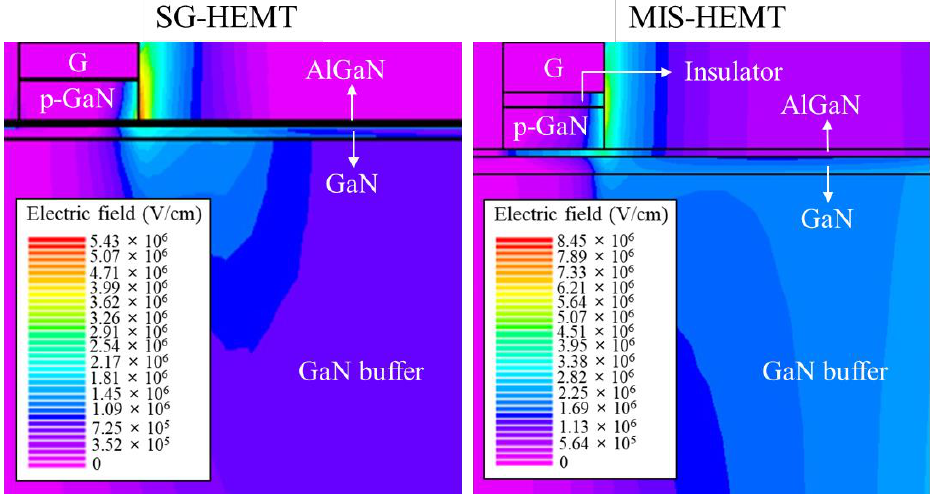
Figure 4. Electric field distributions of the SG-HEMT and MIS-HEMT simulated using TCAD.